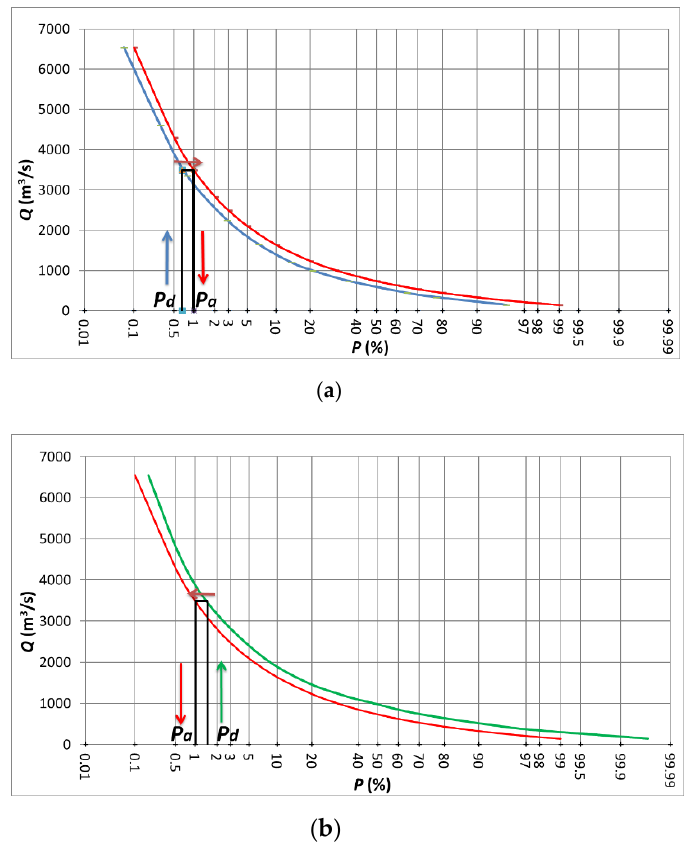
Figure A1. The relationship between the probability of exceedance 𝑃 𝑑 % for the sampling interval d and the annual probability of exceedance 𝑃 𝑎 % : ( a ) 𝑛 > 𝑁 ; ( b ) 𝑛 < 𝑁 . Legend: 𝑃 𝑎 = red line; 𝑃 𝑑 and the annual probability of exceedance P a %: ( a ) n > N ; ( b ) n < N . Legend: P a = red line; P d for for 𝑛 > 𝑁 = blue line; 𝑃 𝑑 for 𝑛 < 𝑁 = green line. n > N = blue line; P d for n < N = green